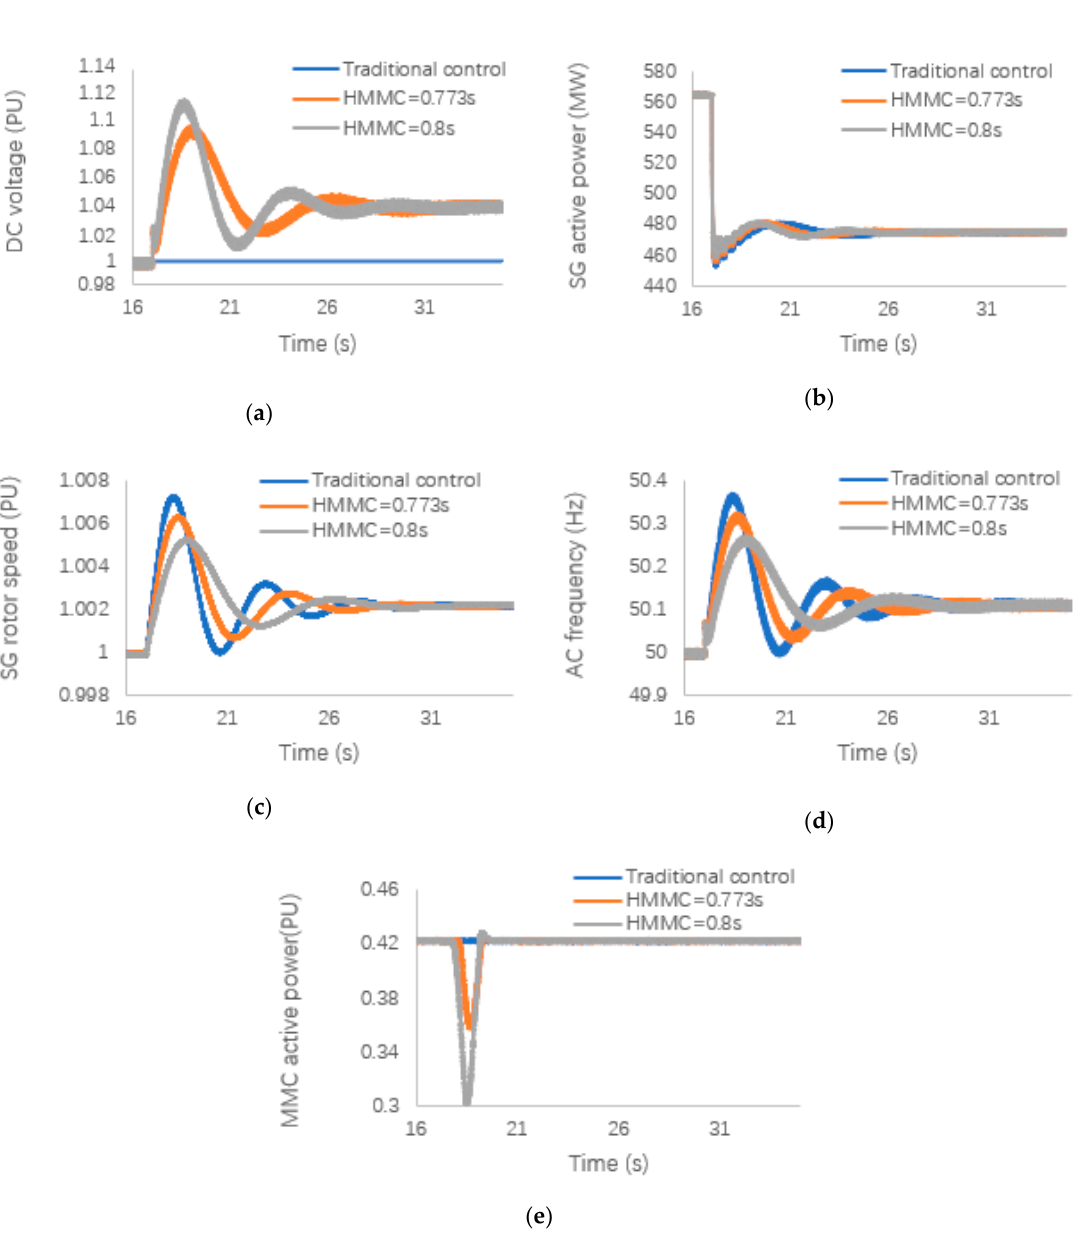
Figure 6. ESCR is 2.5 for 10% load decrease: ( a ) DC voltage; ( b ) SG active power; ( c ) SG rotor speed; ( d ) AC system frequency; ( e ) MMC active power.